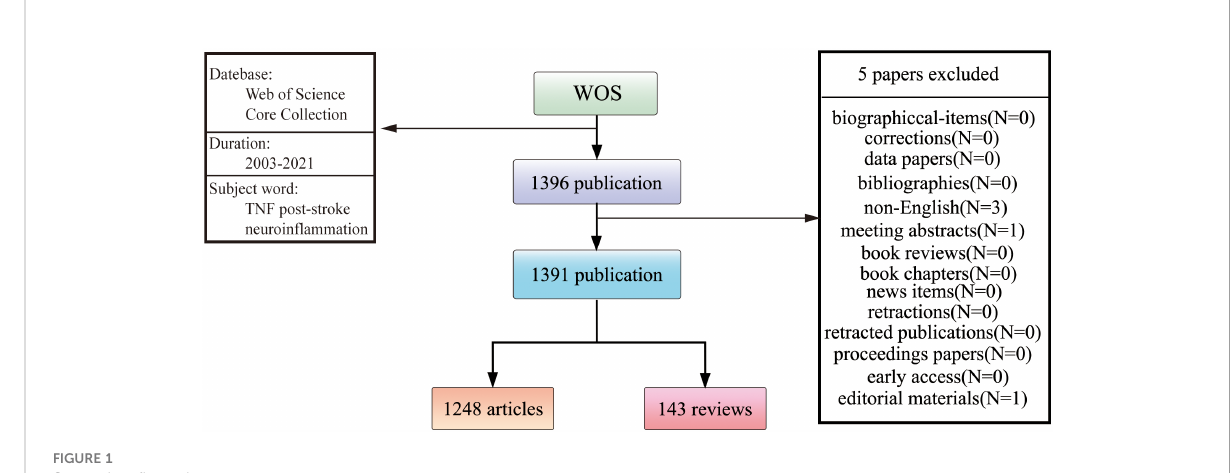
FIGURE 1 Screening fl ow